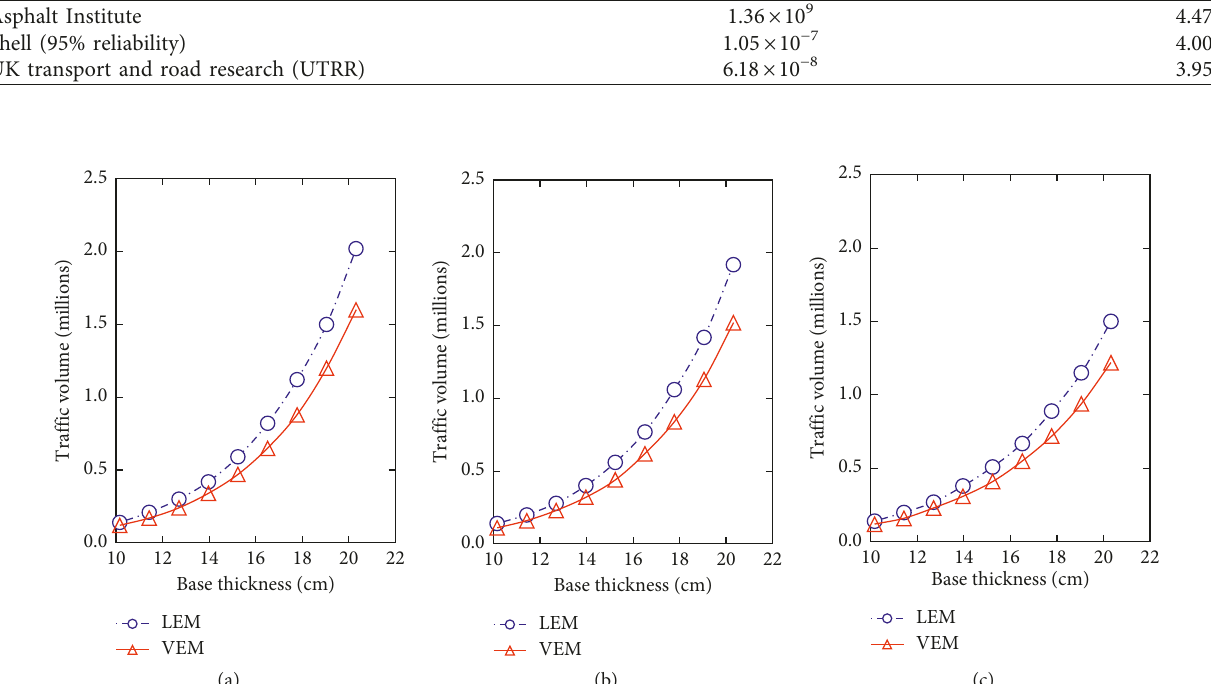
Figure 14: Rutting life of flexible pavement. (a) Asphalt Institute method. (b) Shell method. (c) UTRR method.